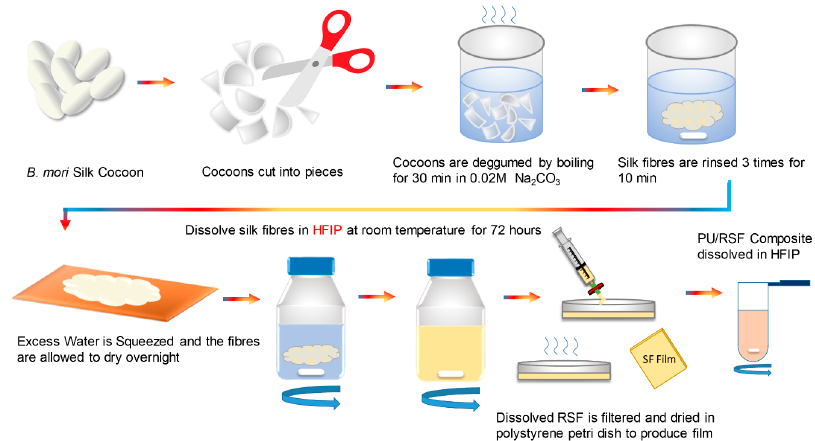
Figure 2. Schematic for PU/RSF polymer composite preparation procedure. Stages involved from cocoons to PU/RSF composite spinning dope.